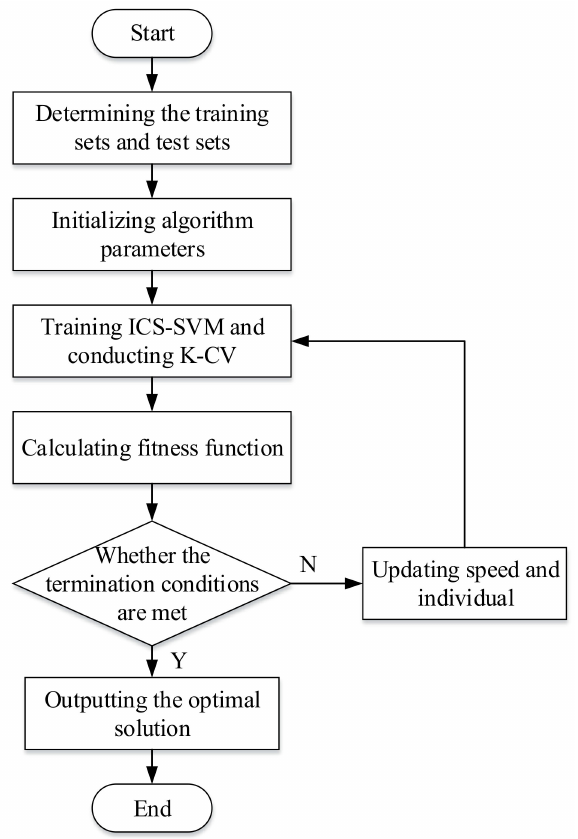
Figure 2. Framework of lead user identification model based on